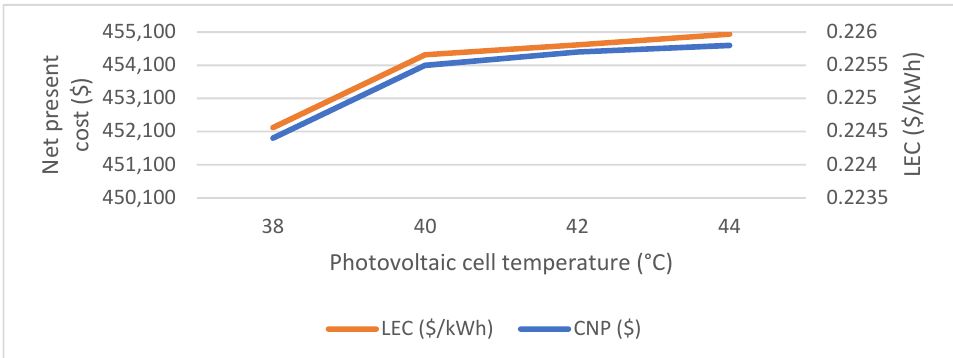
Figure 21. Effect of rising photovoltaic cell temperature on LEC and net present cost.